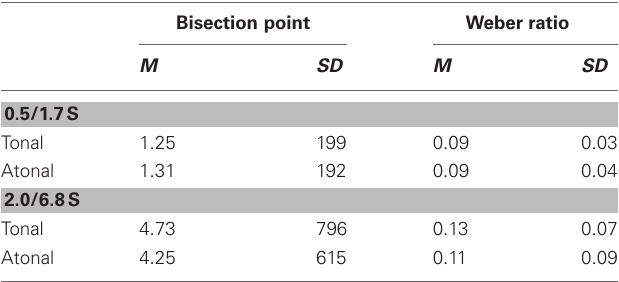
Table 6 | Mean and standard deviation of the Bisection Points and Weber Ratios for tonal and atonal music in the 0.5/1.7 and the 2.0/6.8s duration